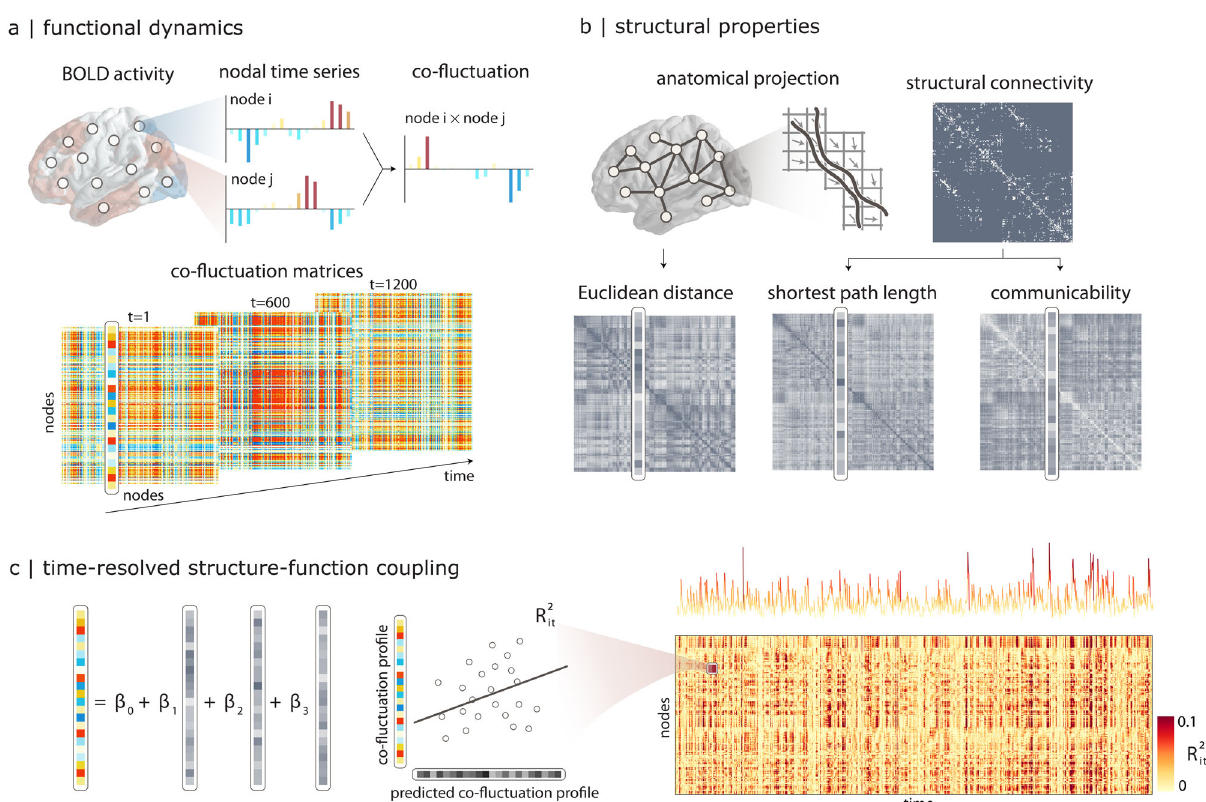
Fig. 1 Time-resolved structure-function coupling. a The co- fl uctuation of two brain regions i and j is calculated as the element-wise multiplication of the two z-scored fMRI BOLD activity time-series. The points of this time-series can be represented as one element in a co- fl uctuation matrix. b Pairwise structural relationships are derived from structural connectivity networks reconstructed from diffusion MRI, including Euclidean distance between node centroids, shortest path length and communicability. c A multilinear regression model is used to predict a region ’ s co- fl uctuation pro fi le from its structural pro fi le, using Euclidean distance, path length and communicability as predictors. The resulting coef fi cient of determination ( R 2 i ; t ) indicates how well the structural connectivity pro fi le predicts the functional connectivity pro fi le for a particular brain region i at a particular time point t . The procedure generates a region × time matrix that captures the fl uctuation of structure-function coupling for individual regions across time. The time-series shows time- resolved fl uctuations in mean R 2